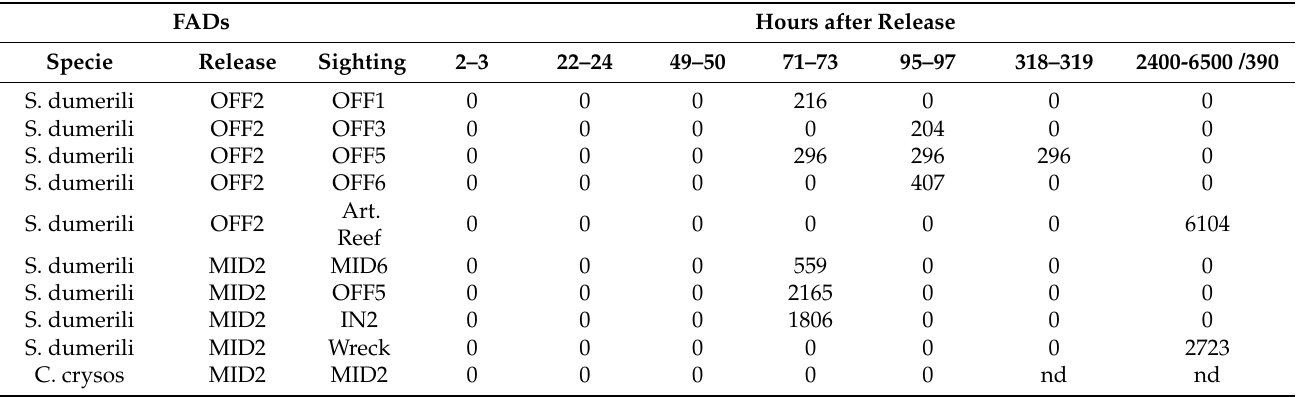
Table 2. List of sites of FAD release, sighting, and distance (in meters) travelled by tagged fishes in the successive